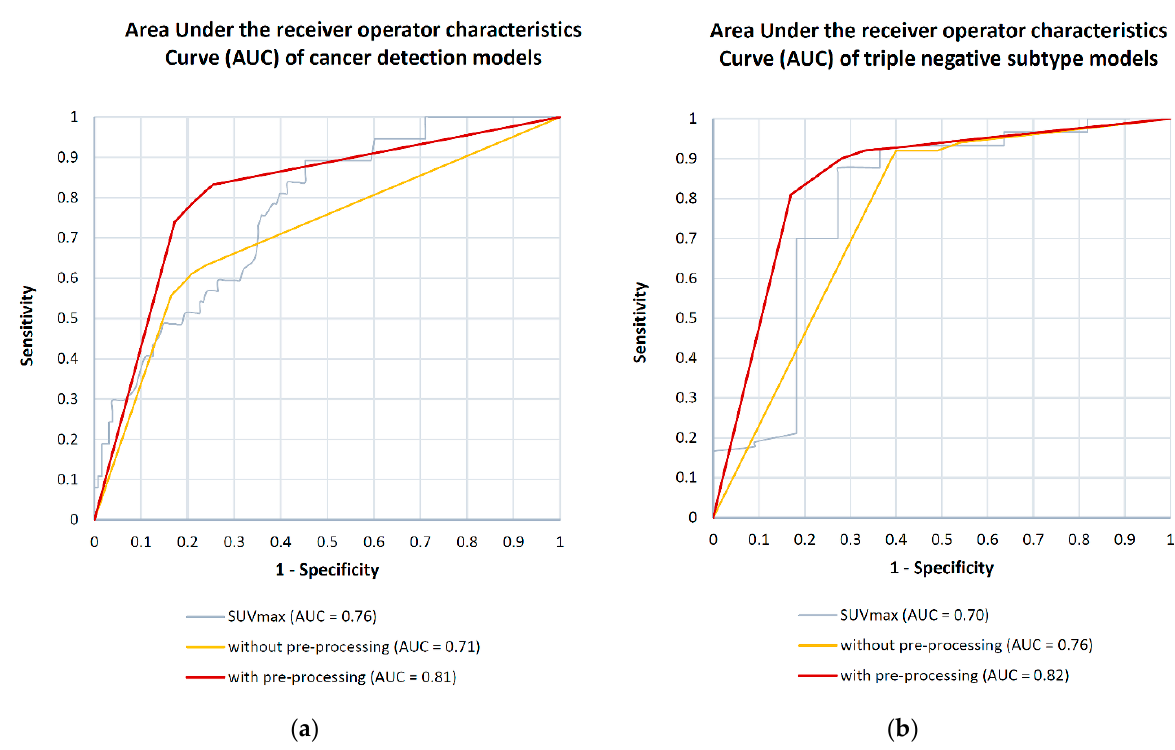
Figure 7. Comparison of area under the receiver operator characteristics curve (AUC) performance of maximum standard uptake value (SUV max ) and holomics-based ensemble models with and without data pre-processing for ( a ) breast cancer detection ( b ) triple negative subtype.